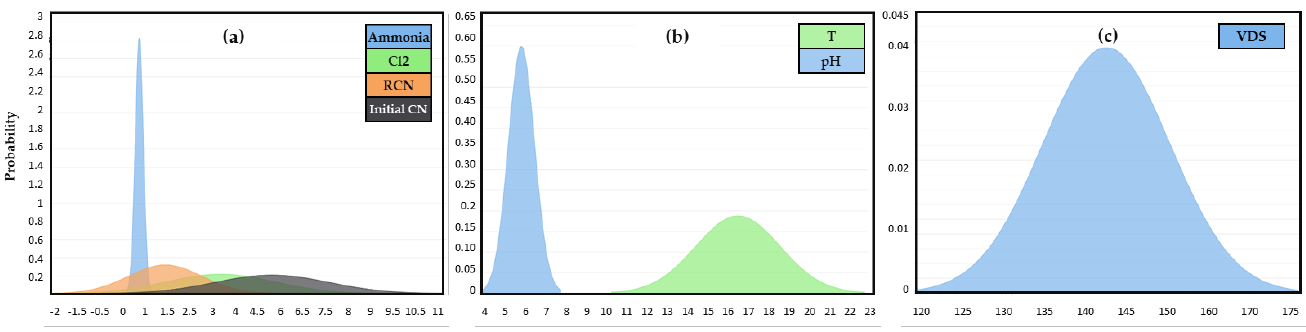
Figure 10. The normal diagram of available data in the present research. ( a ) Initial CN/Injected chlorine, ammonia, and RCN; ( b ) T and pH; ( c ) VDS.